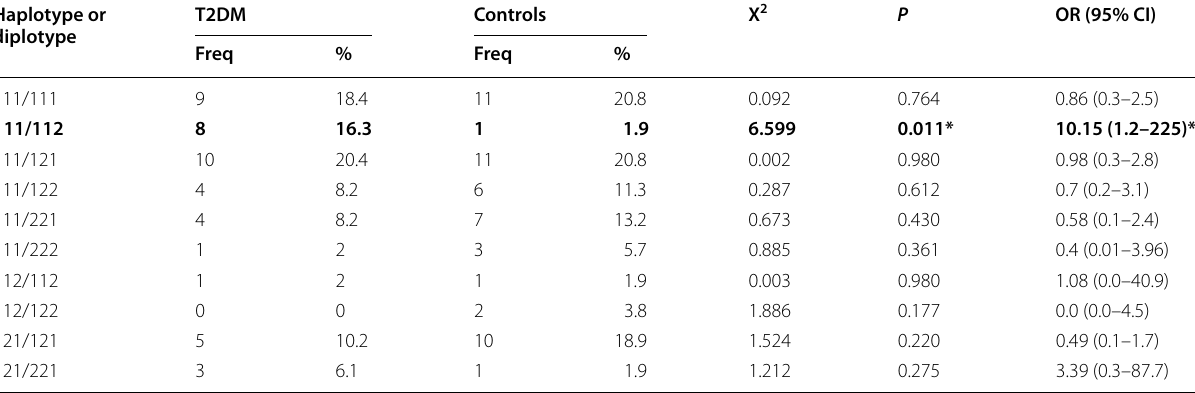
Bold indicates statistical significant result *Significant value at P < 0.05 Table 2 The clinical characteristics of patients’ classified according to MS